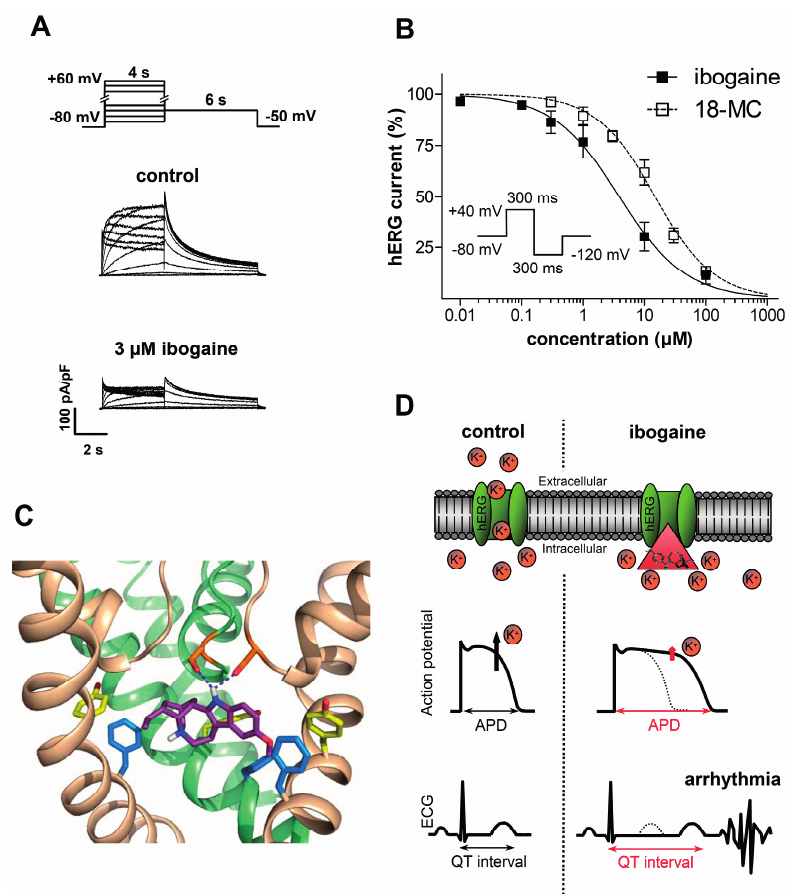
Figure 2. hERG channel inhibition by ibogaine and 18-MC, and its consequences for cardiac electrophysiology. ( A ) Original hERG potassium currents in the absence (control) and presence of ibogaine recorded with the whole cell configuration of the patch clamp technique. hERG channels were heterologously expressed in TSA-201 cells and voltage clamped by the protocol depicted on top. This figure part was taken with permission from [17] (figure 1b) where all experimental details can be found; ( B ) Concentration-response relations for hERG current inhibition by ibogaine (IC 50 , 4 µM) and 18-MC (IC 50 , 15 µM). Currents were elicited by the protocol shown in the inset. Taken with permission from [17] (figure 2c); ( C ) Binding pocket of ibogaine within the hERG channel as revealed by molecular drug docking. hERG inner cavity with flanking S6 helices and pore loops (brown and green). Only three side chains are shown for clarity: residues Tyr652 (yellow) and Phe656 (blue) of the S6 helices and residues Ser624 (orange) on the pore loop as part of the selectivity filter. Ibogaine in its protonated form is shown in purple. Hydrogen bonds are shown as blue dotted lines. Taken with permission from [60] (figure 6); ( D ) Suggested mechanism of cardiac arrhythmia induction by ibogaine: ibogaine blocks hERG potassium channels from the intracellular side (top) and thereby retards repolarization of the ventricular AP (middle). Consequently, the QT interval in the ECG is prolonged (bottom), which finally enhances cardiac arrhythmia